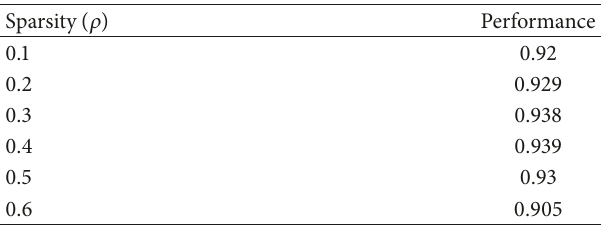
Table 7: Performance comparing with other methods.